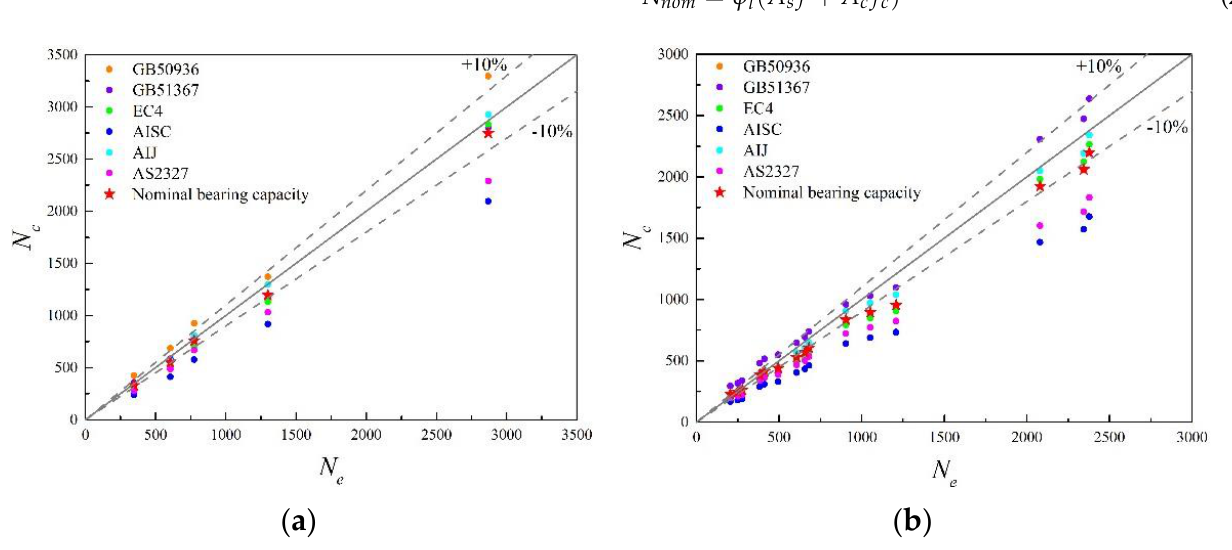
Figure 16. Comparison of design values and test results. ( a ) composite members without prepress; ( b ) composite members with prepress.